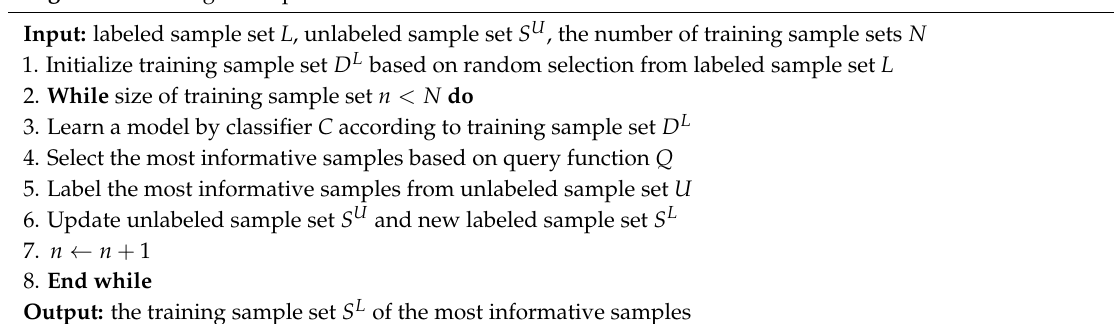
Algorithm 1. The general process of